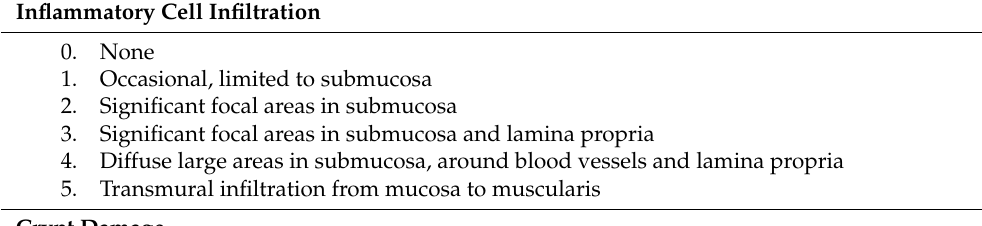
Table 2. Histopathological lesion score